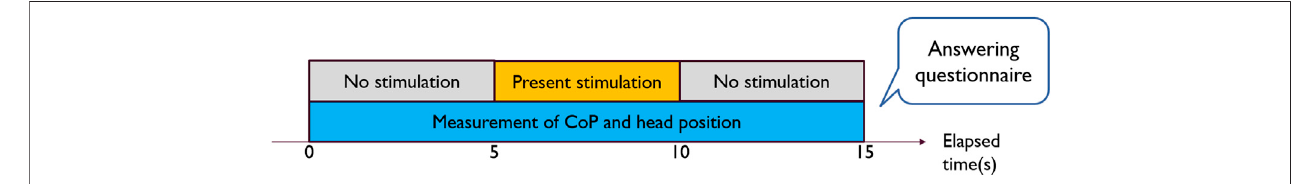
FIGURE 5 | Time sequence of tendon electrical stimulation and measurement of the centre of pressure (CoP) and head position.